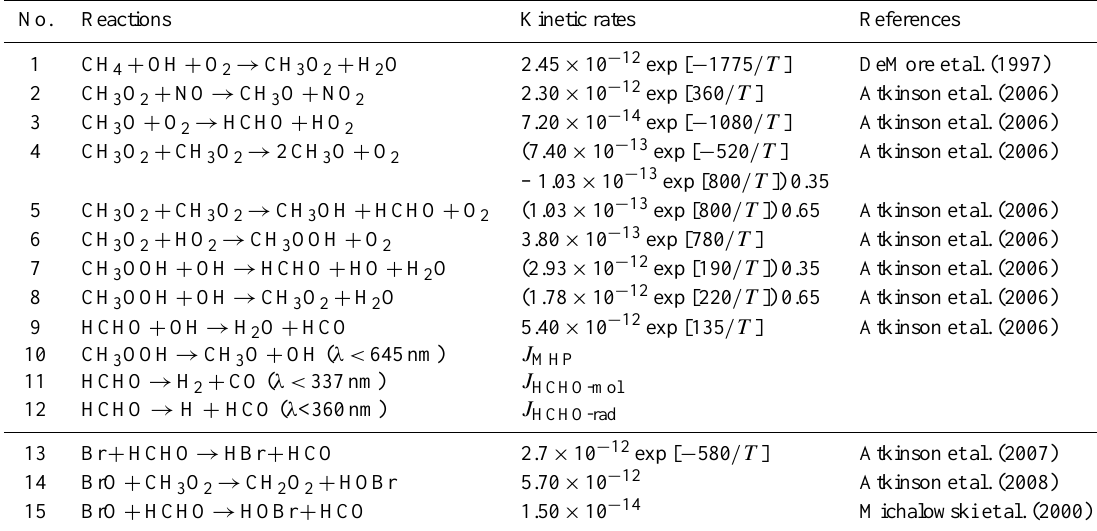
Table 1. Gas-phase reactions included in the 1-D model (see Sect. 2.4). Kinetic rates are given in cm 3 molecules − 1 s − 1 . HCHO and MHP (CH 3 OOH) photolysis rates are shown in Fig.